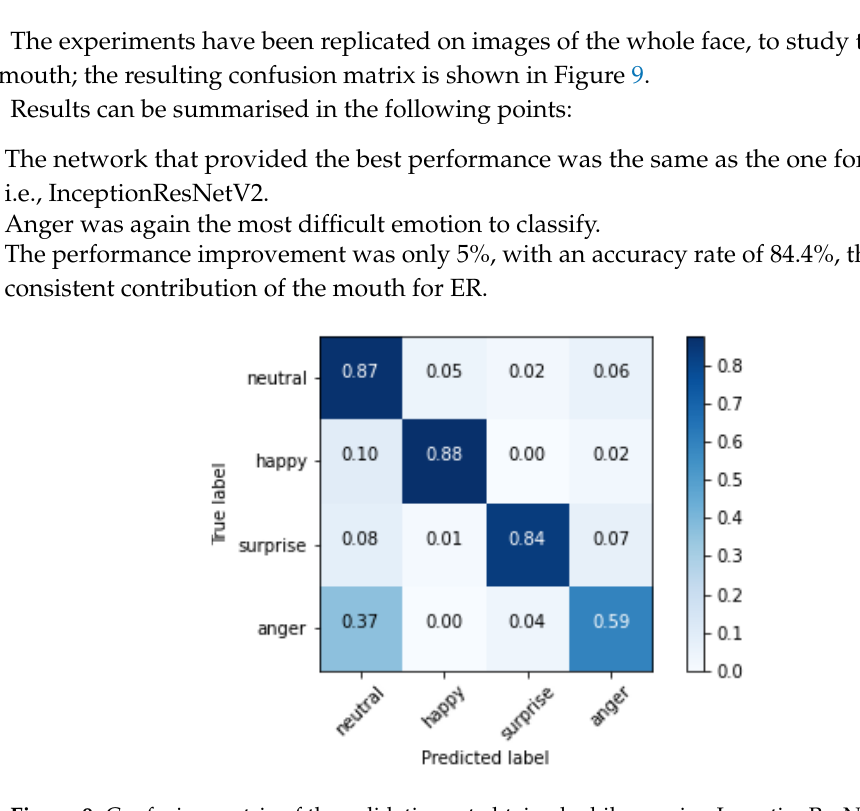
Figure 9. Confusion matrix of the validation set obtained while running InceptionResNetV2 to analyse the whole face images instead of the mouth portions of the